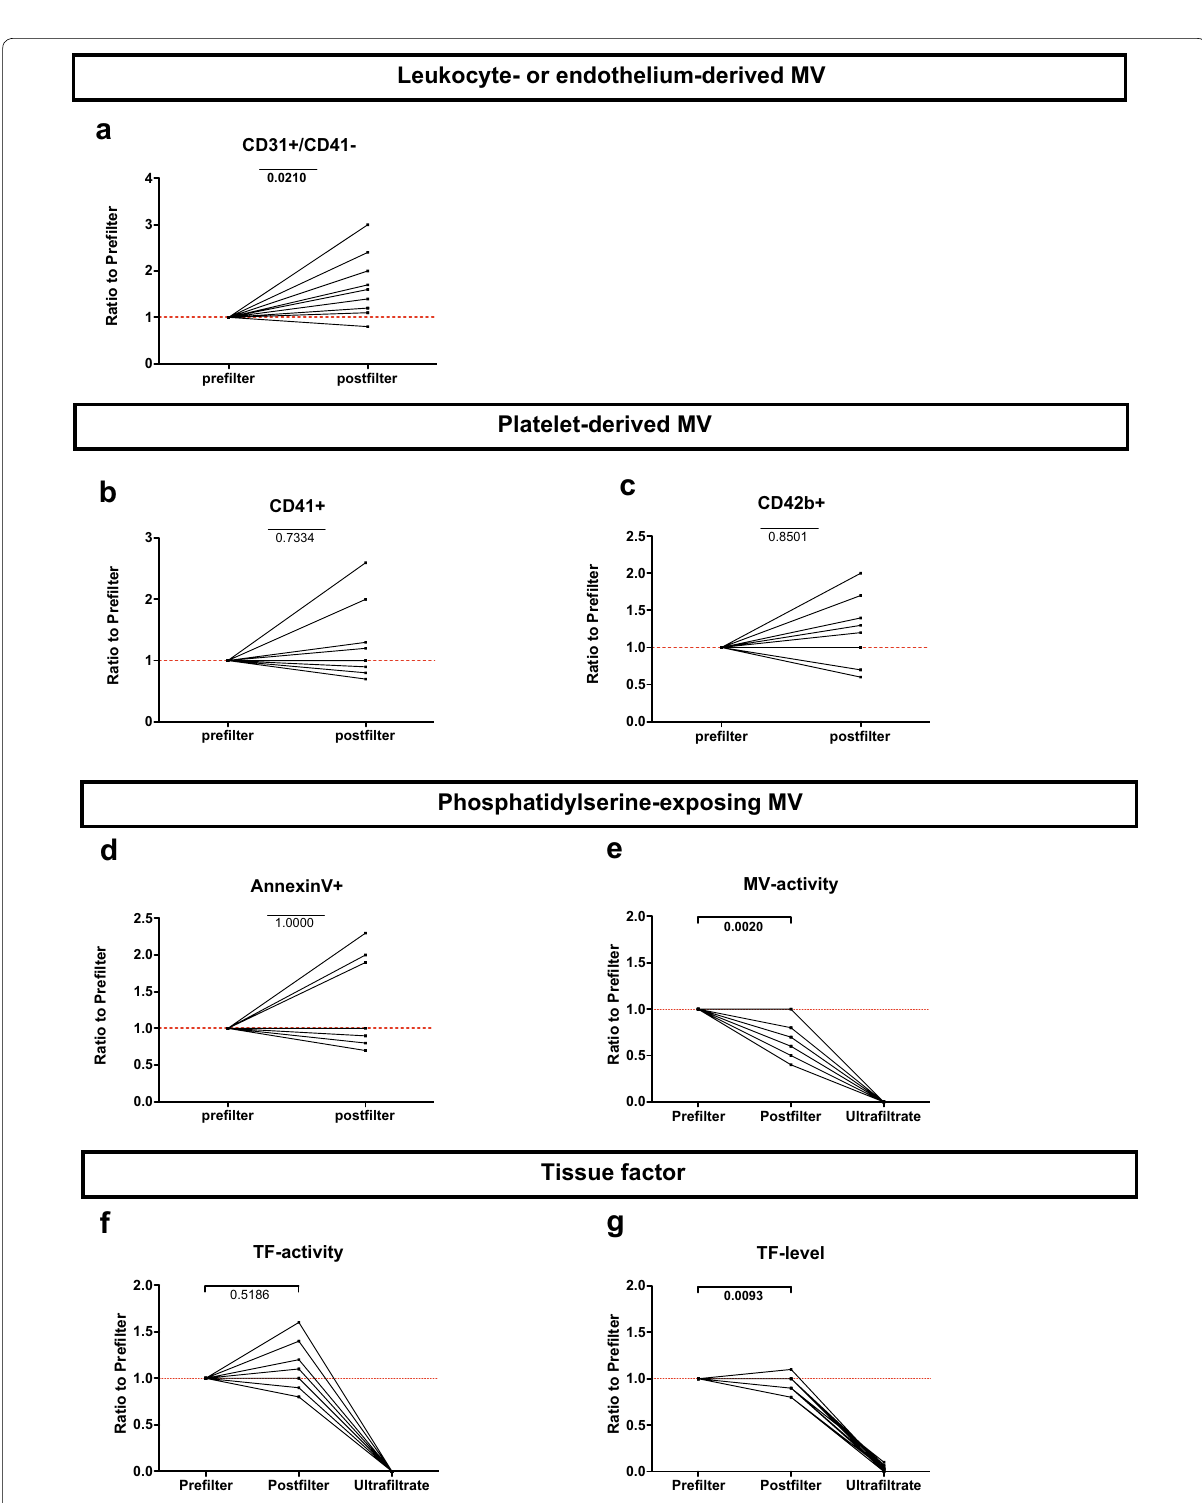
Fig. 1 Postfilter-to-prefilter ratios of MV subsets, MV activity, TF activity and TF level. P values refer to the comparison of absolute amounts per minute pre- to